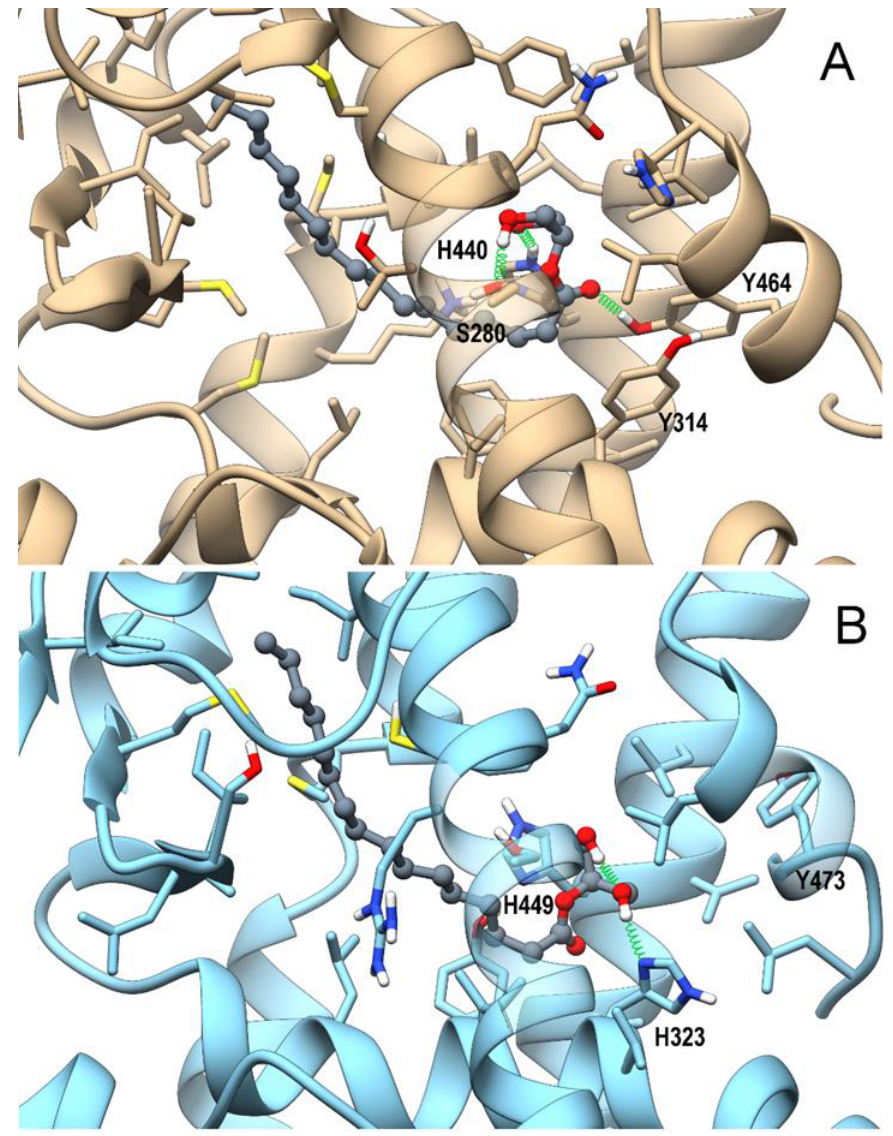
Figure 4. Theoretical complexes of PPARα (tan) ( A ) and PPARγ (light blue) ( B ) with 2-PG colored in dark grey and shown in ball & stick representation. Protein residues within 5 Å from the ligands are shown in stick representation. H-bonds are shown as green springs. Hydrogen, nitrogen, oxygen, and sulfur atom are painted white, blue, red, and yellow, respectively. A transparent surface for ribbons was used wherever they hide the ligand-binding site.